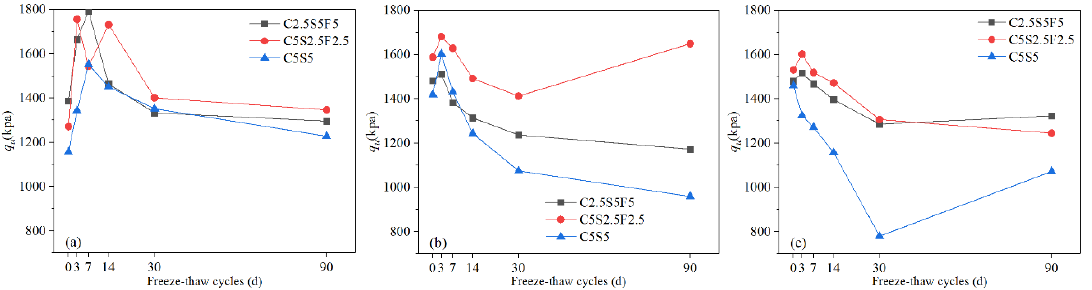
Figure 5. The UCS of Pb-CSCSs with the same contaminant content and different compound binders: ( a ) 0.05% Pb 2 + ; ( b ) 0.5% Pb 2 + , and ( c ) 1% Pb 2 + ( a ) 0.05% Pb 2+ ; ( b ) 0.5% Pb 2+ , and ( c ) 1% Pb 2+ .